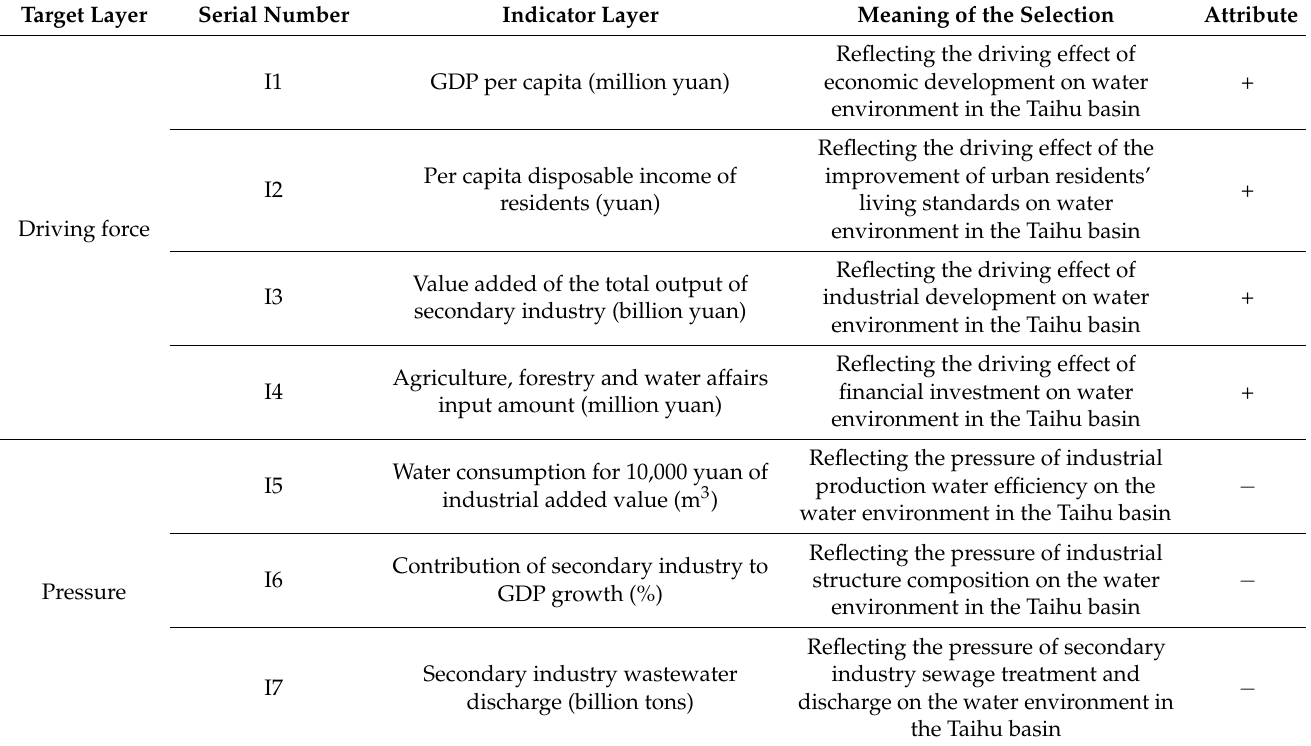
Table 1. The evaluation index system based on the DPSIR